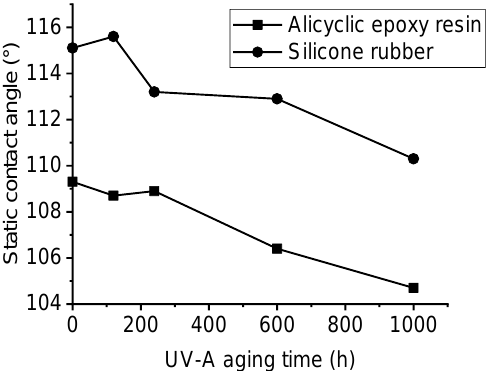
Figure 9. Static contact angle at different UV-A aging times of two samples.